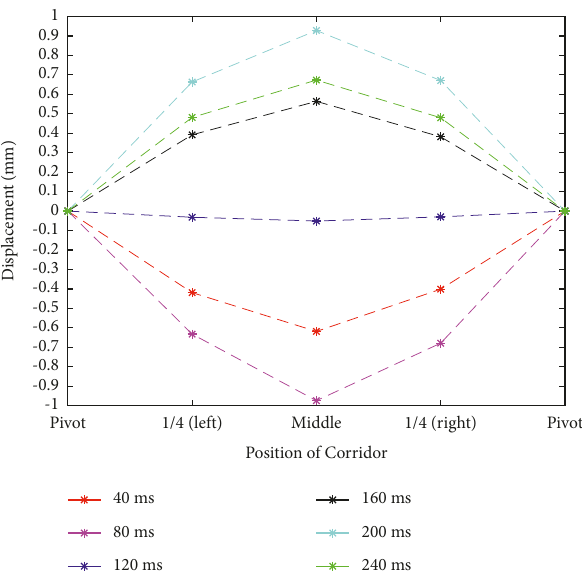
Figure 10: Real-time displacement curve of the